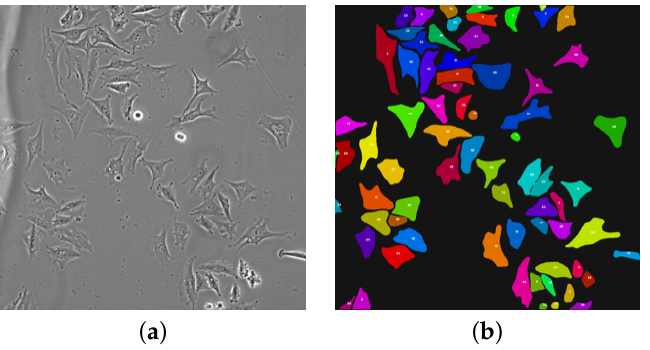
Figure 4. Example data from the Usiigaci dataset [63]: ( a ) original image (20180101ef002xy01t01.tif); ( b ) corresponding indexed mask, where each color indicates a different cell in all sequence images. Table 3. Details of annotated data for cellular event detection and classification in traditional label-free sequences: dataset name (Name); reference ([Ref]); application of the data (Task); type of microscopy data (Content); url (Link); number of annotated images (# imgs), and number of annotated events (# events). All links were accessed on 28 August